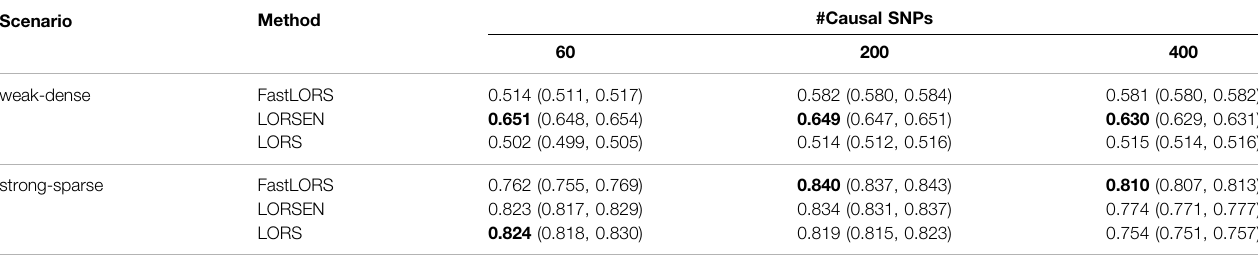
TABLE3| TheaverageAUCand95%con fi denceintervalwithouttheSNPscreeningwithtenreplicatesforeachsimulationscenario.SNPsareonlyfromchromosome1.For each simulation scenario, the highest AUC is in bold.